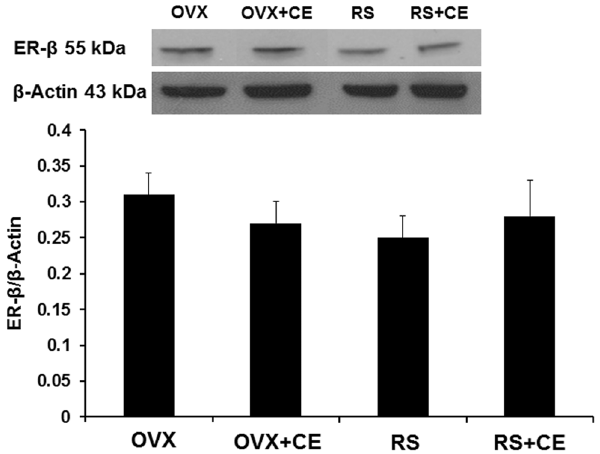
Figure 3. Estrogen treatment did not have any effect on ER- b expression in post-ischemic cerebral microvessels of young ovariectomized (OVX) or old reproductively senescent (RS) rats. Values of ER- b are expressed as a ratio to b -actin and presented as mean 6 SD. Data are from three independent gels, with n=3 per group.